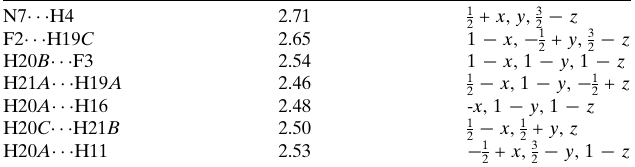
Table 2 Summary of short interatomic contacts (A˚ ) in the title compound. N7 (cid:3)(cid:3)(cid:3) H4